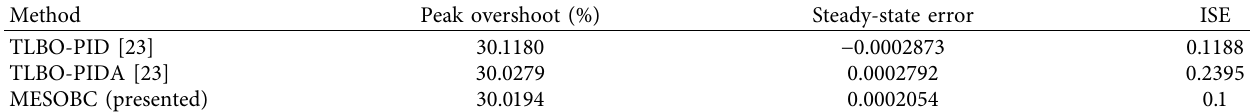
g and ± 30% load voltage variation.